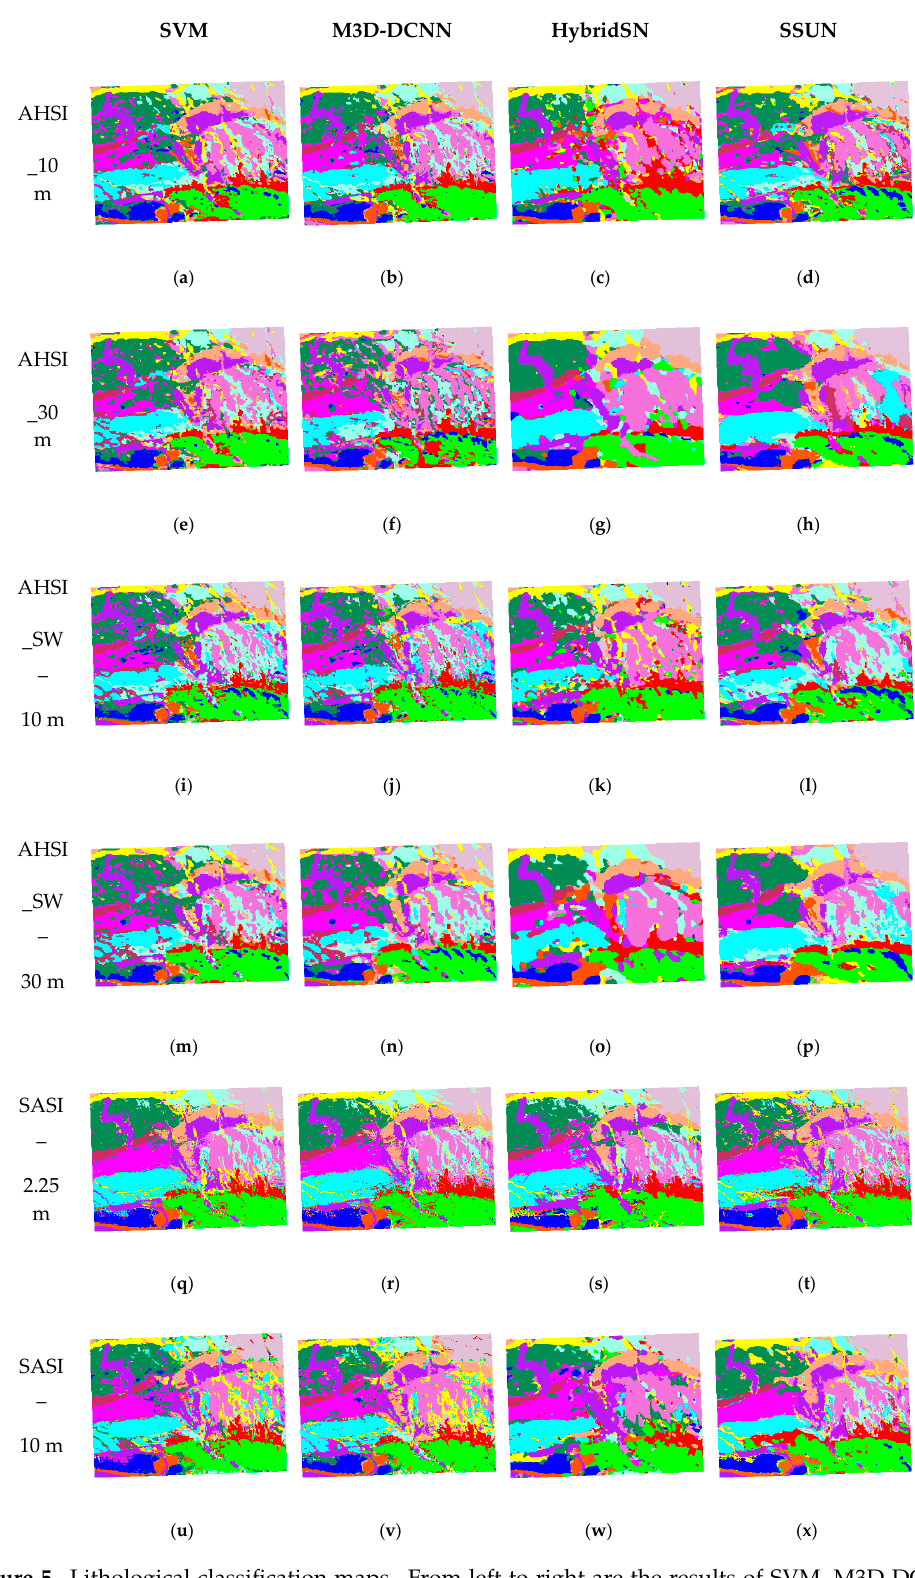
Figure 5. Lithological classification maps. From left to right are the results of SVM, M3D-DCNN, HybridSN, and SSUN. Each row of results was produced from the same dataset, and different rows represent different datasets. From top to bottom are the results of AHSI_10 m ( a – d ), AHSI_30 m ( e – h ), AHSI_SW_10 m ( i – l ), AHSI_SW_30 m ( m – p ), SASI_2.25 m ( q – t ), and SASI_10 m ( u – x ) datasets.